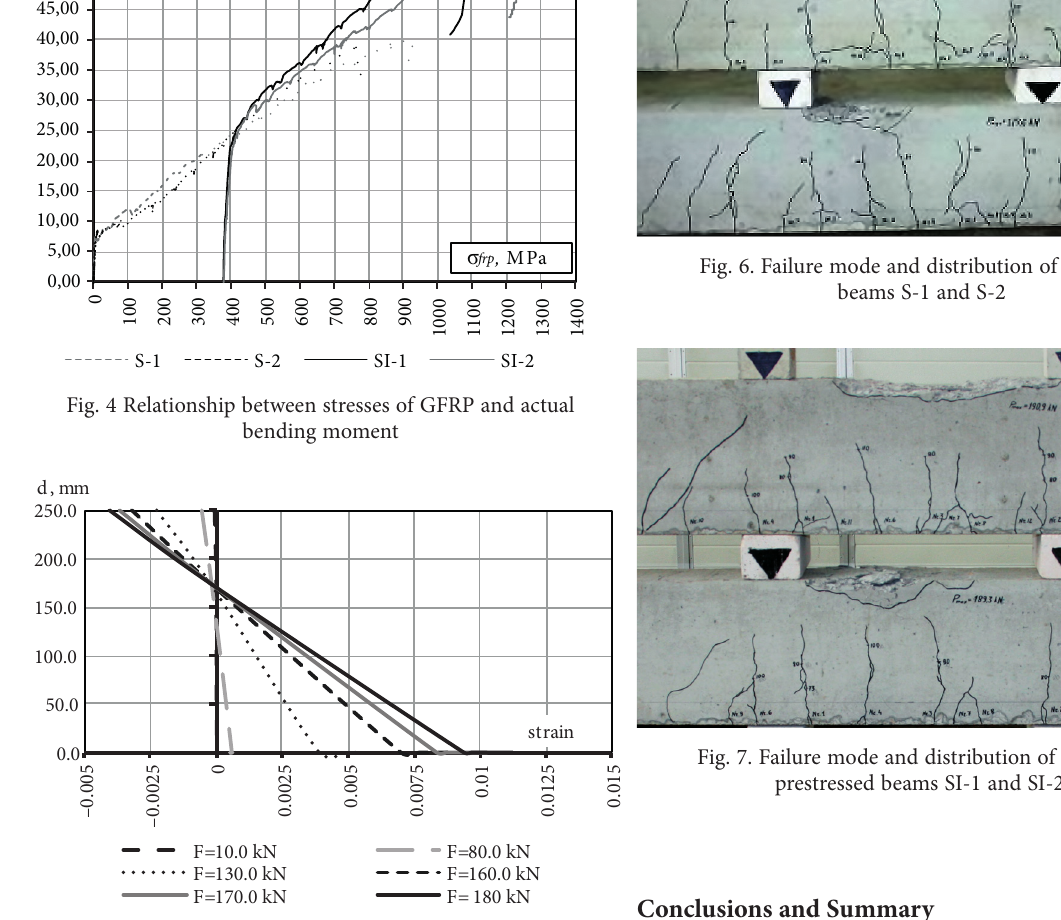
Fig. 5. Distribution of strain in the cross section of the beam SI-2